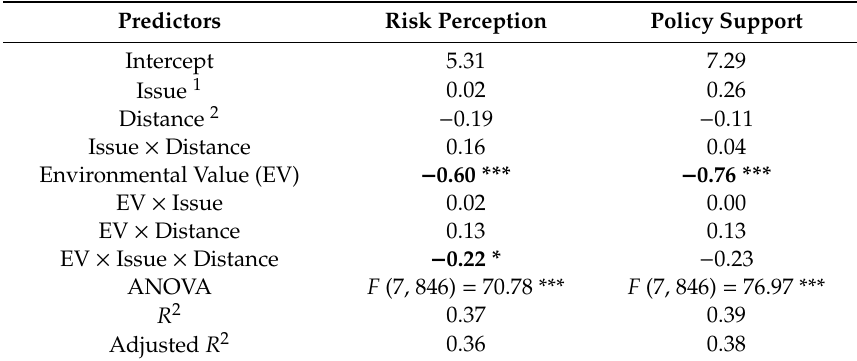
Figure 3. Distance framing and political ideology interacted to influence polarization. Table 2. Regression models predicting risk perception and policy support with message frames, environmental value and their interaction (unstandardized regression coe ffi